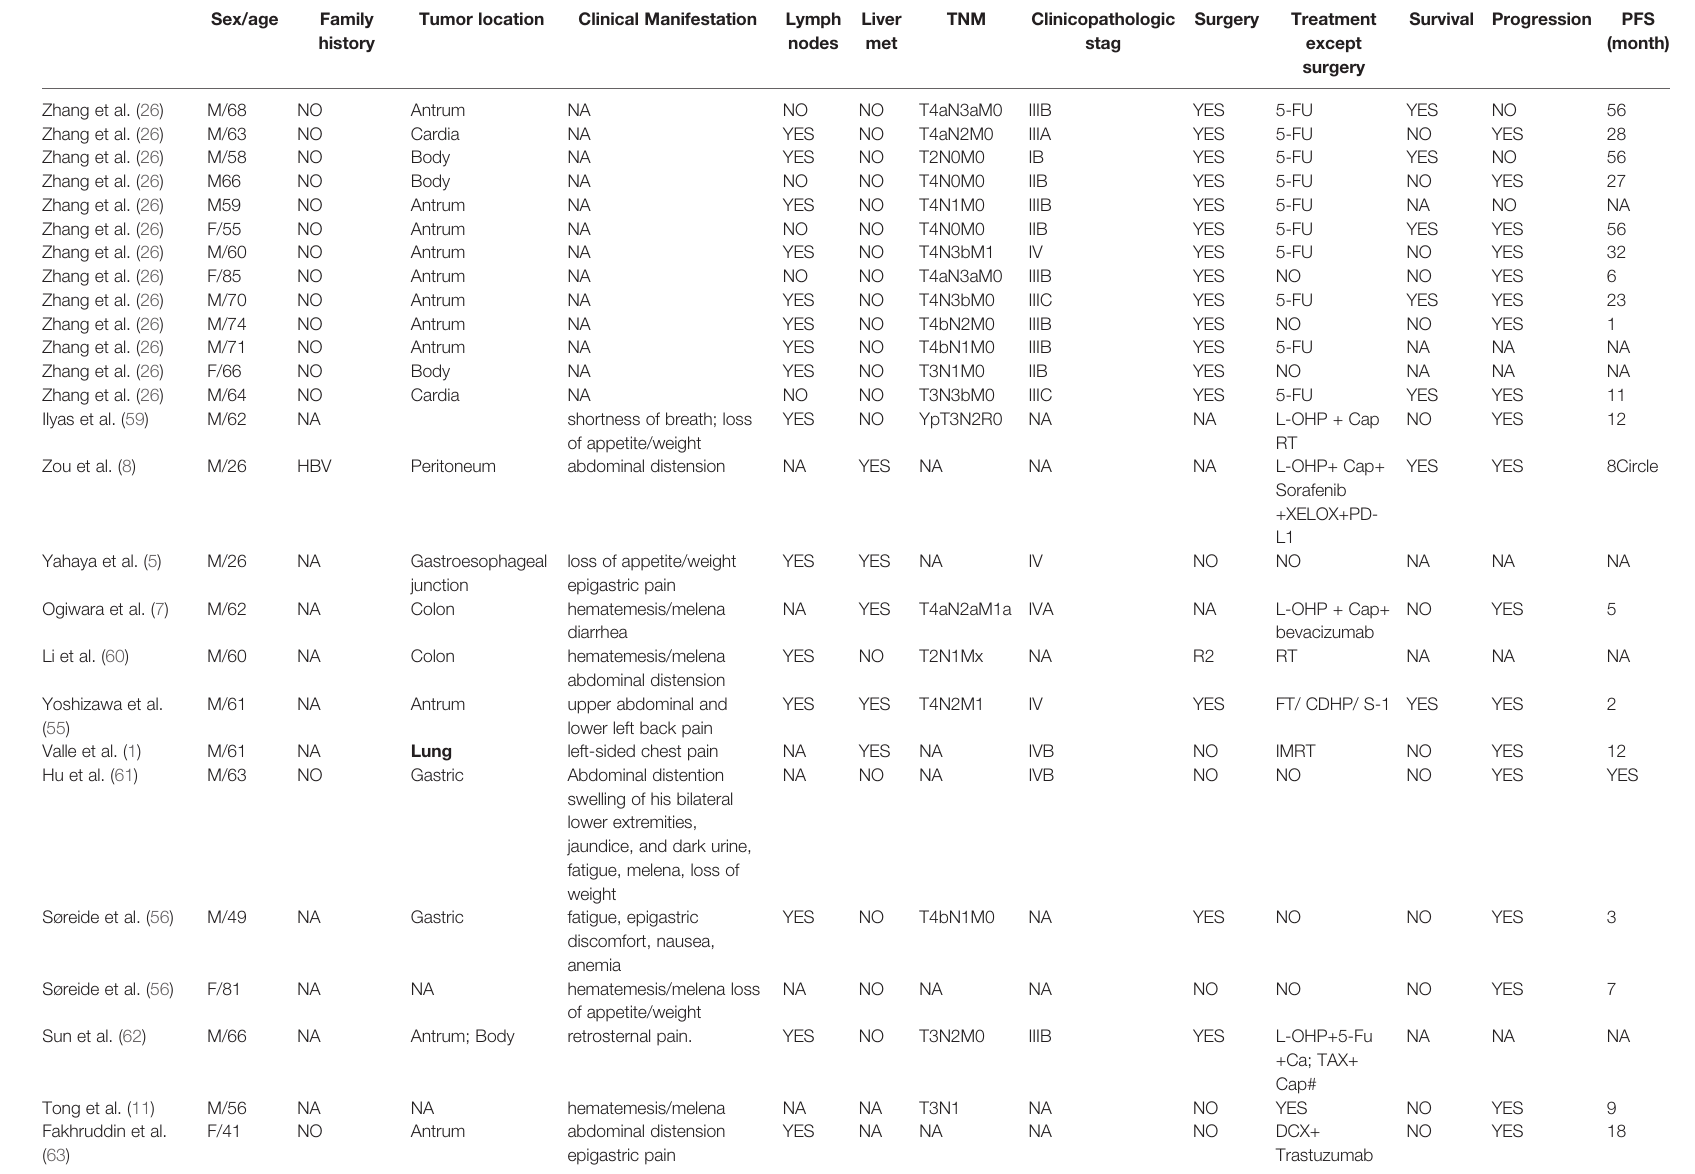
TABLE 1 | Baseline